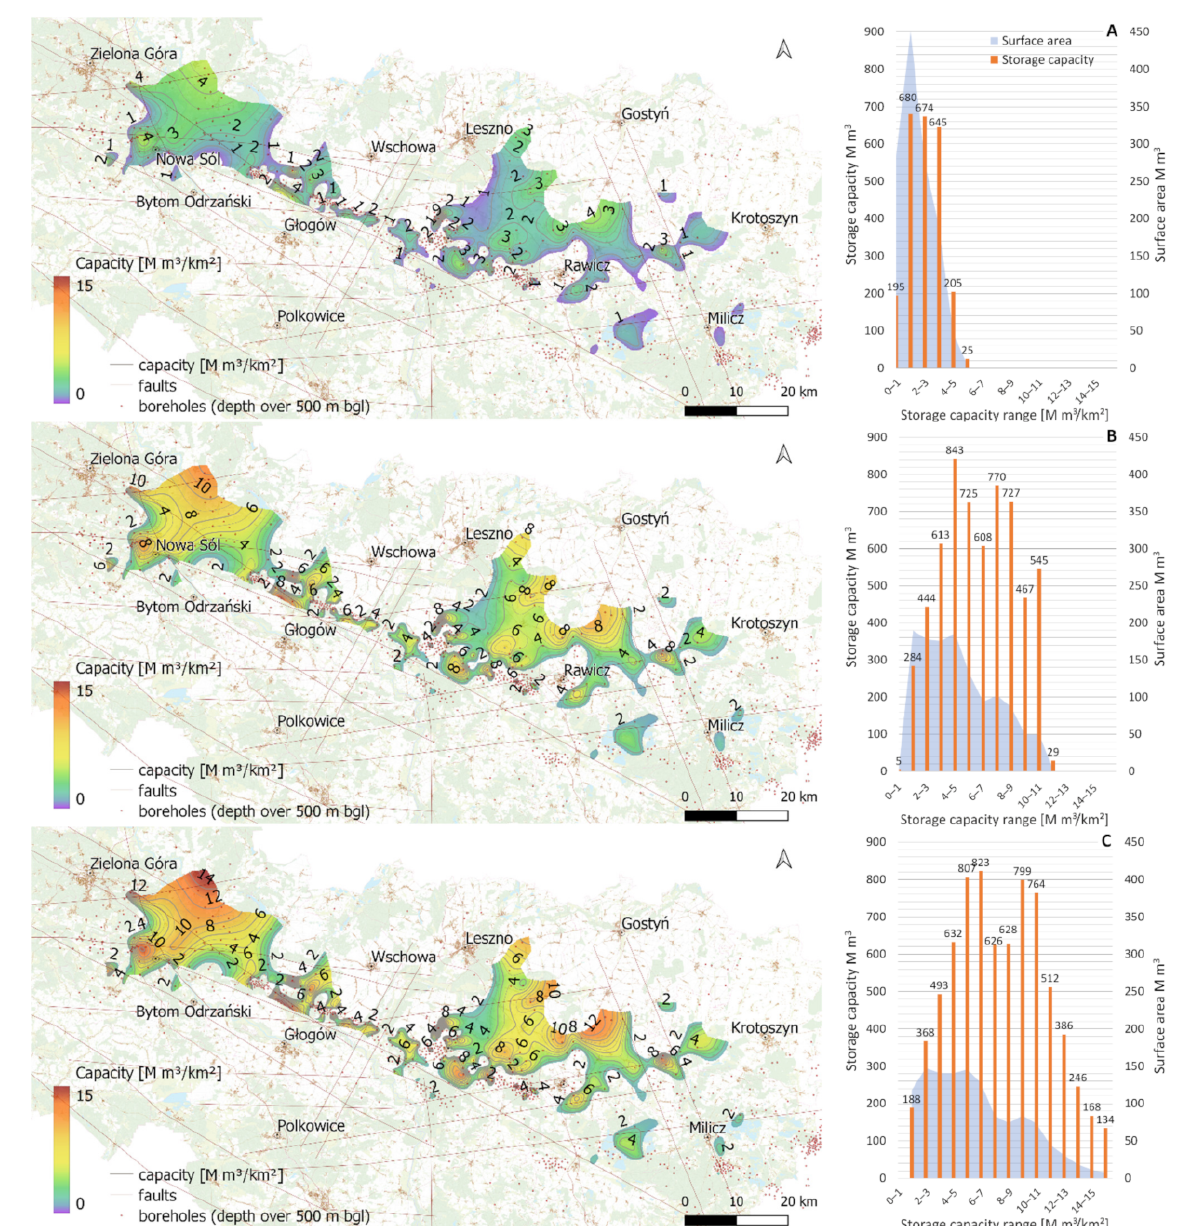
Figure A6. The storage capacity of liquid fuels in the rock salt layer in the central part of the Fore- Sudetic Monocline (( A ) initial state of operational storage, ( B ) target state of operational storage, ( C ) strategic